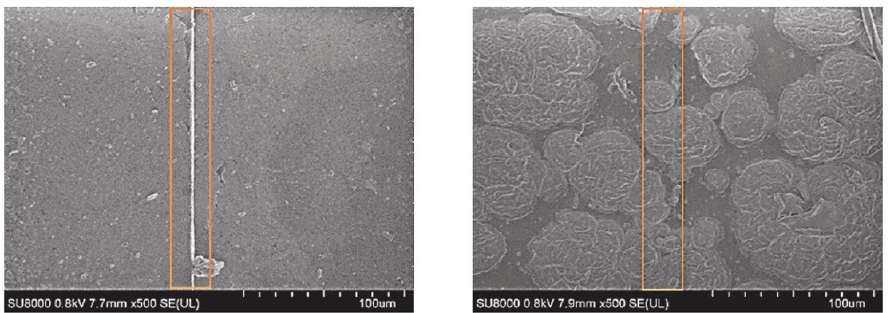
Figure 8. SEM micrograph of sulfur-based SBR compound before ( left ) and after ( right ) healing protocol. Reproduced with permission from [50]. 2022, Elsevier.